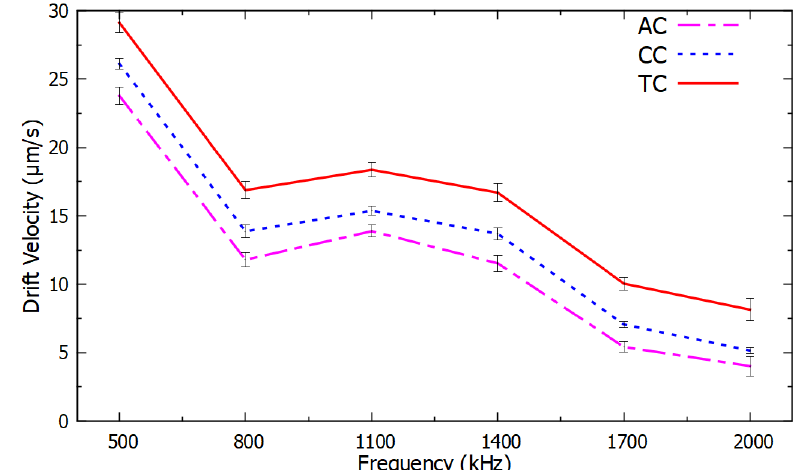
Figure 6. Negative DEP spectra for di ff erent nucleotides adjacent to the last nucleotide of ssDNA